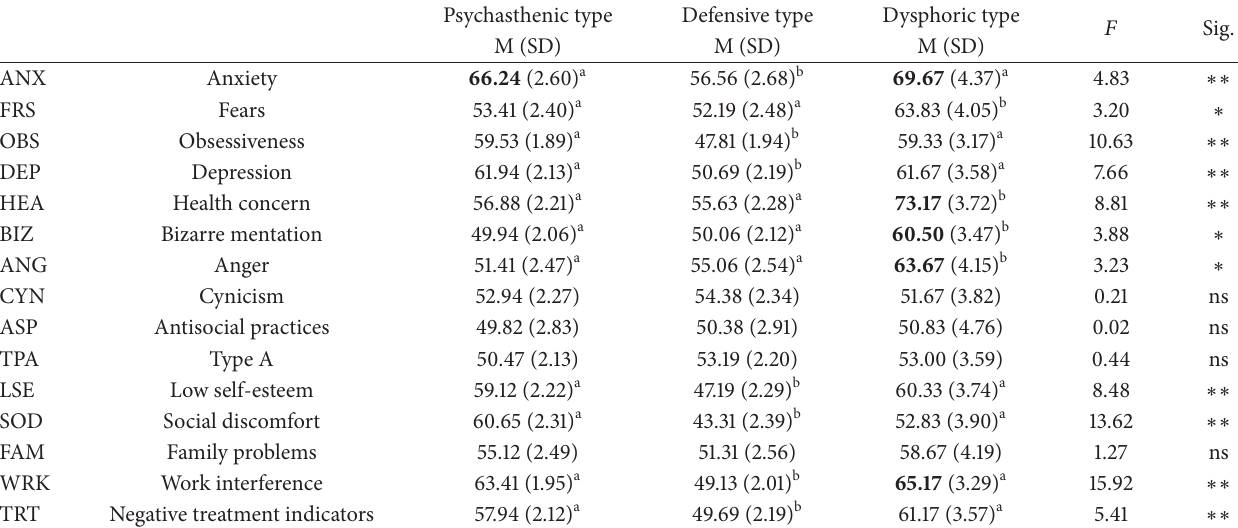
Table 3: MMPI-2 content scales: mean 𝑇 -scores and standard deviations of three groups